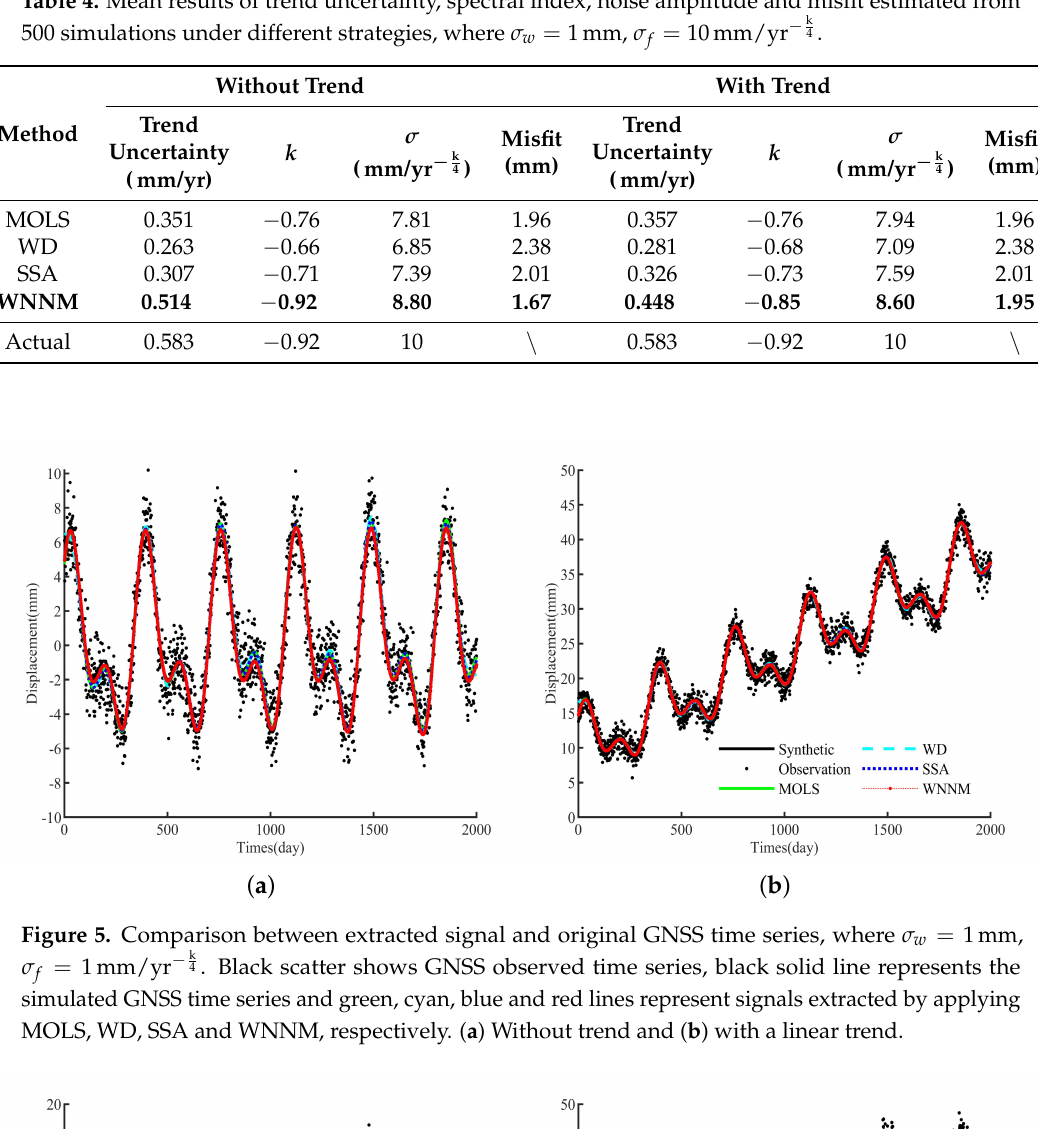
Table 4. Mean results of trend uncertainty, spectral index, noise amplitude and misfit estimated from